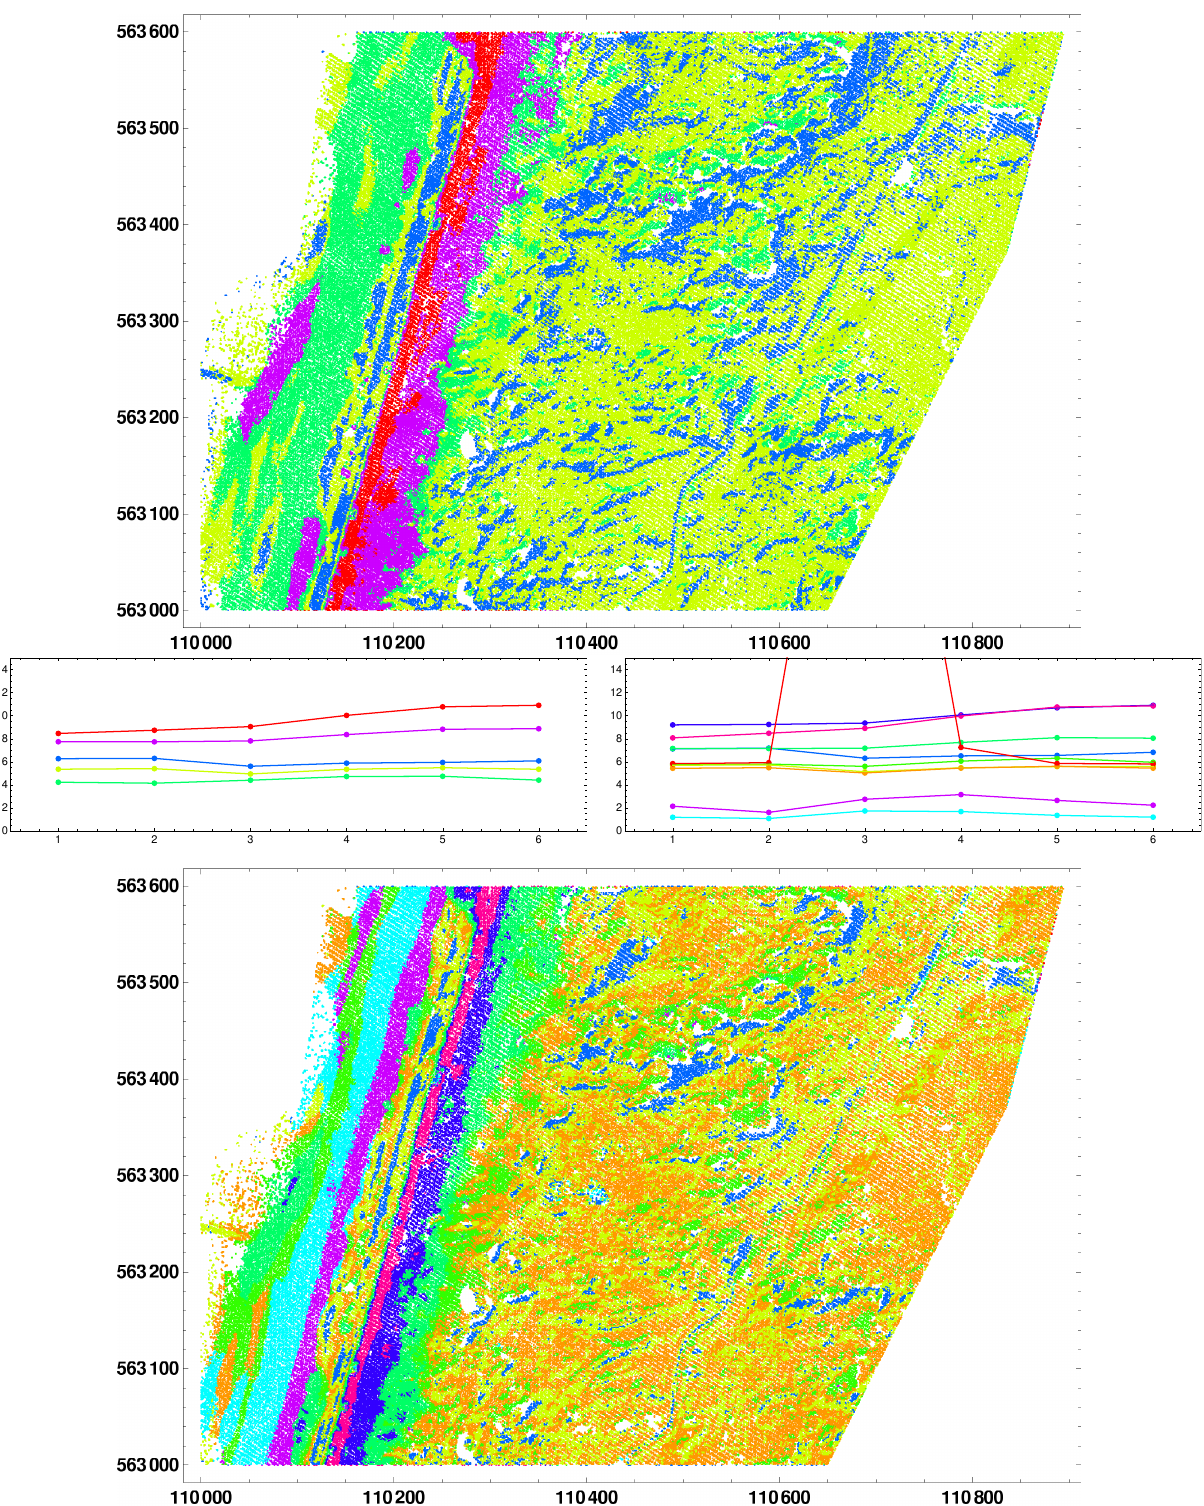
Figure 5. K-means clustering results for ALS-TEXEL. The top figure shows one result for k=5. The bottom figure shows one result for k=10. In both cases, time series locations are colored by cluster. In the middle, for each cluster, the mean of all time series belonging to that cluster is shown. The middle left shows the mean time series corresponding to the k=5 case of the top, while the middle right corresponds to the k=10 case at the bottom. The colors in the time series plots correspond to those in the spatial